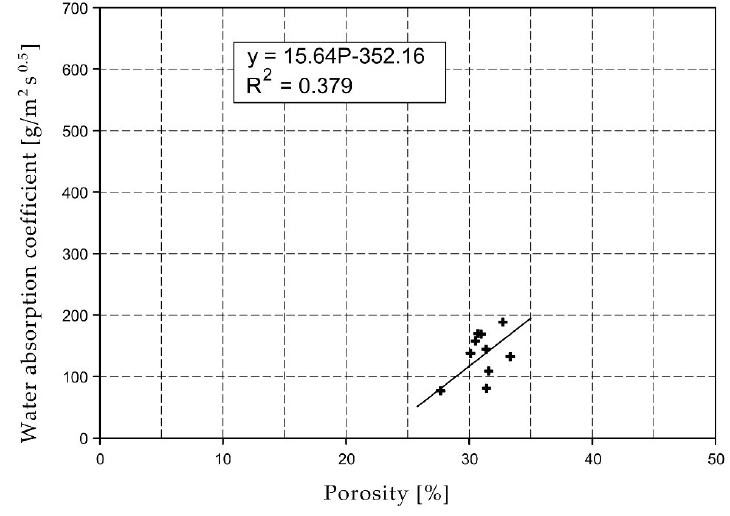
Figure 11. Water absorption coefficient of O06XX series bricks.